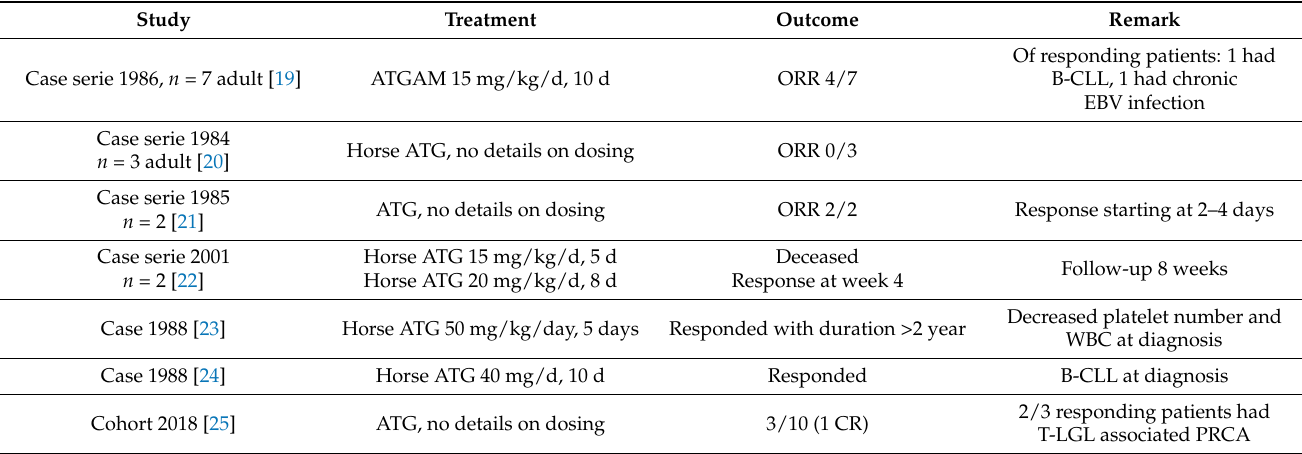
Table 3. Published studies on ATG as treatment in acquired PRCA. d: days, ORR: overall response rate, CR: complete remission. Study Treatment Outcome